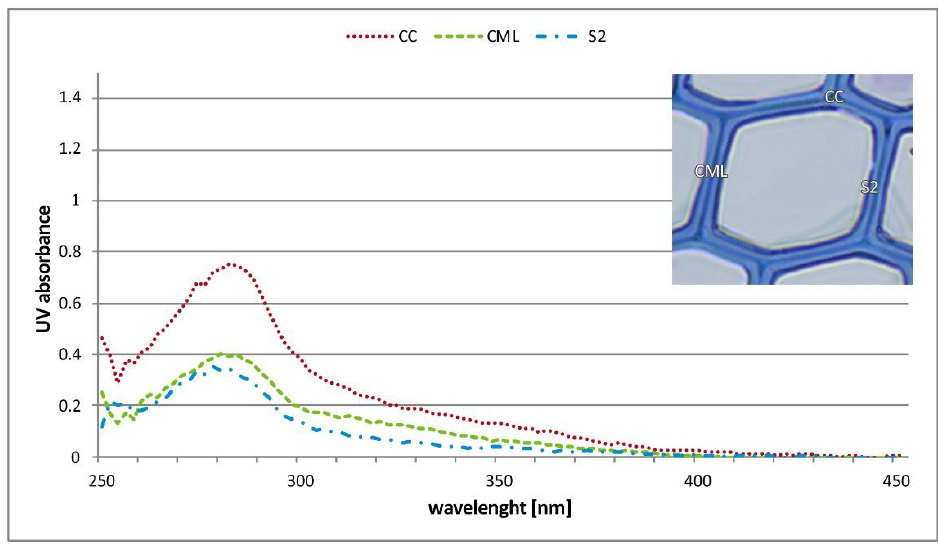
Figure 7. UV absorbance spectra of individual cell wall layers in the wooden tissue of PM 1 (AC 0%) (CC — cell corner, CML — compound middle lamella, S2 — secondary wall).